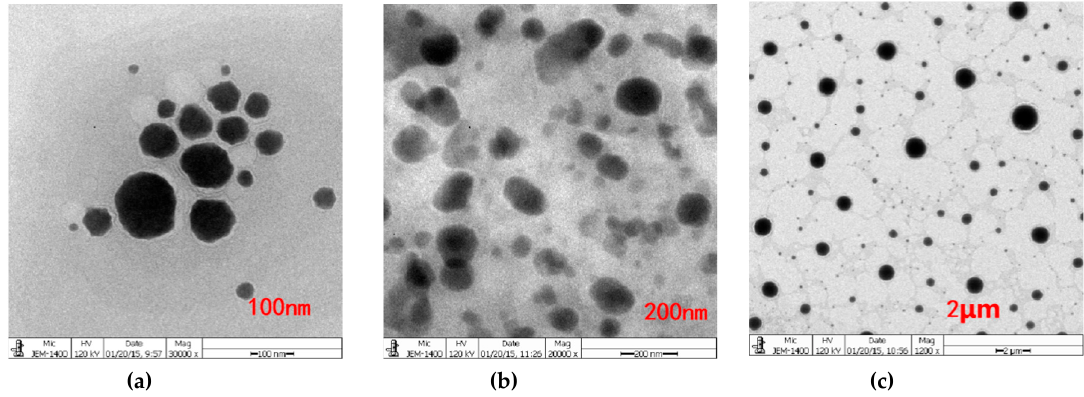
Figure 3. Transmission electron microscopy (TEM) images of the Span60-RH40-system in the mass ratio of at 9:11 with different scales of ( a )100 nm, ( b )200 nm, ( c )2 μ m. Niosomes were formed.